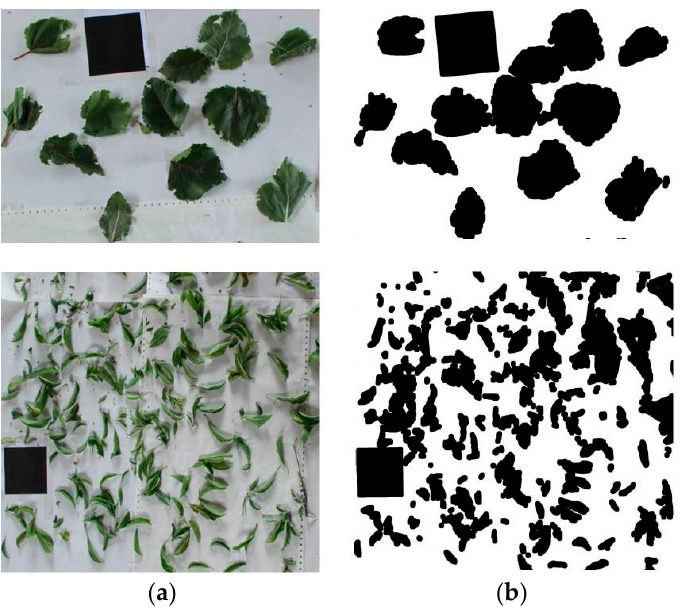
Figure 2. RGB images ( a ) used to quantify the leaf area, after their transformation to binary images ( b ) and subsequent application of the Otsu’s thresholding method. Upper side corresponds to a poplar sample. Down side corresponds to a plum-tree sample. A 100 cm 2 black square was included in each image as reference area.